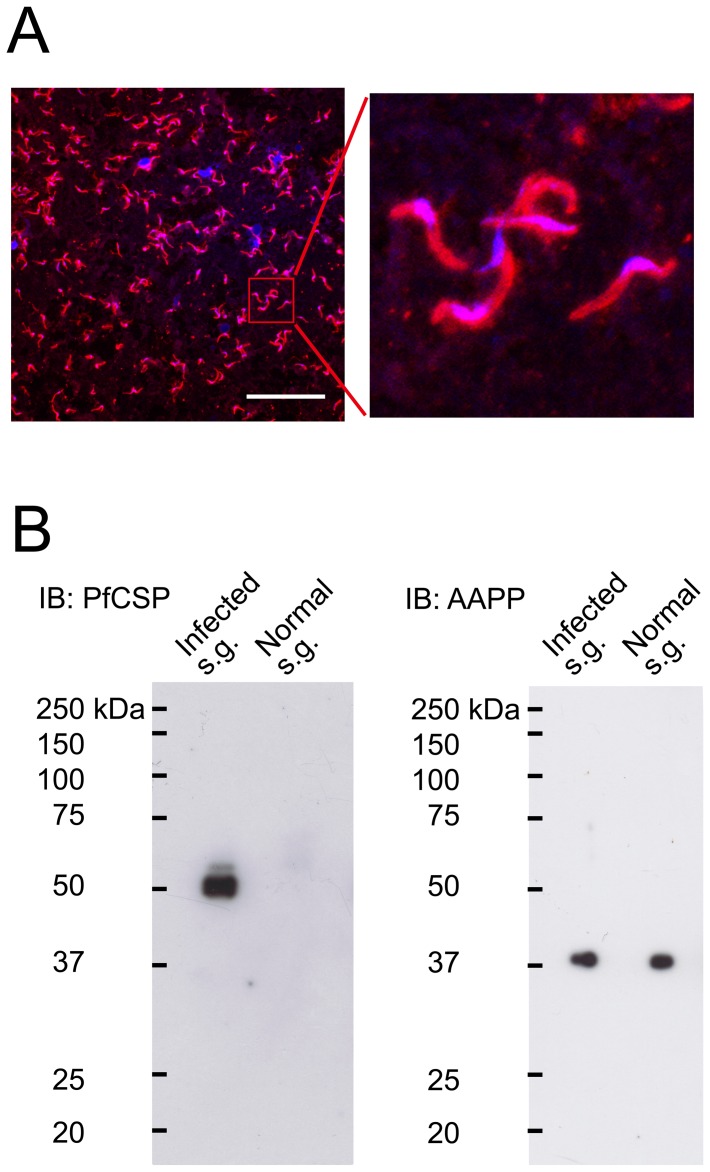
PfCSP expression in transgenic P. berghei.(A) Confocal laser scanning microscopy PfCSP expression in transgenic P. berghei. Salivary glands from the infected mosquitoes as well as transgenic P. berghei sporozoites were probed with the 2A10 mAb conjugated to Alexa Flour 594 (red). Parasite nuclei and mosquito salivary glands were visualized by DAPI (blue). Bar = 50 µm. (B) Salivary glands from uninfected mosquitoes or mosquitoes infected with the transgenic parasites were lysed and loaded onto 10% gels, and then immunoblotted with the 2A10 mAb and anti-AAPP mAb (28B8).